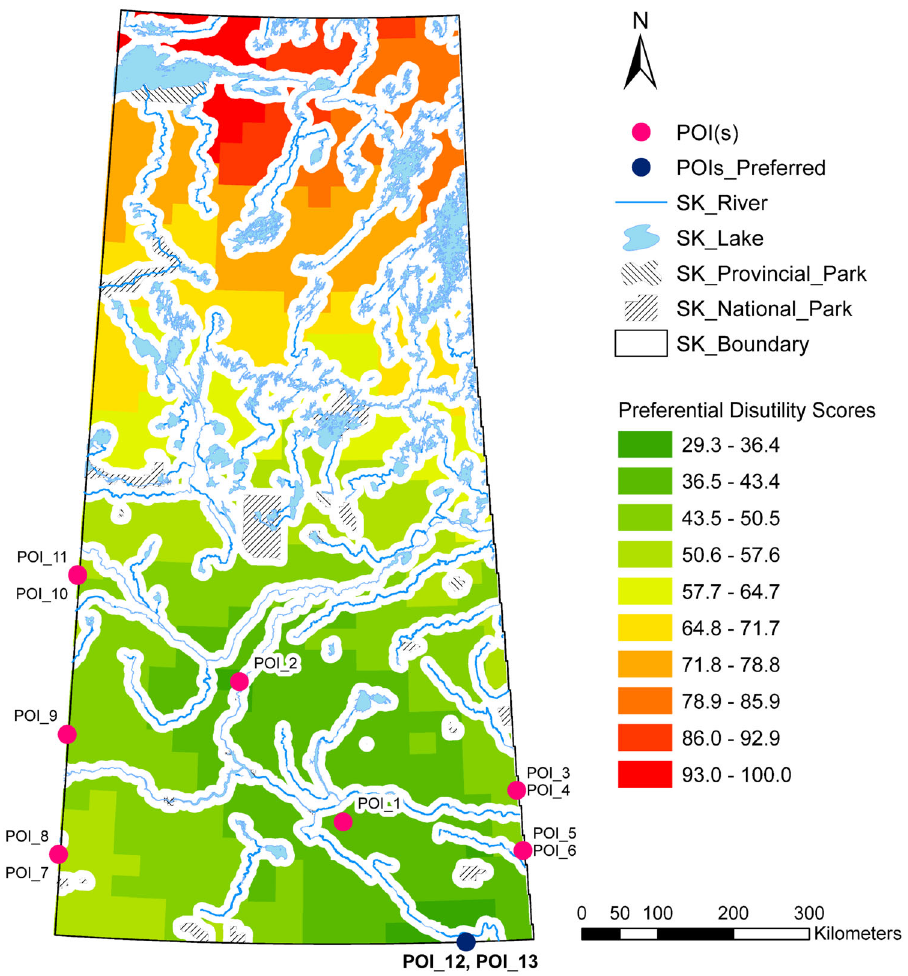
Fig. 11 Case III heat map showing the impact of preferential treatment of POI_12 and POI_13 ( b =